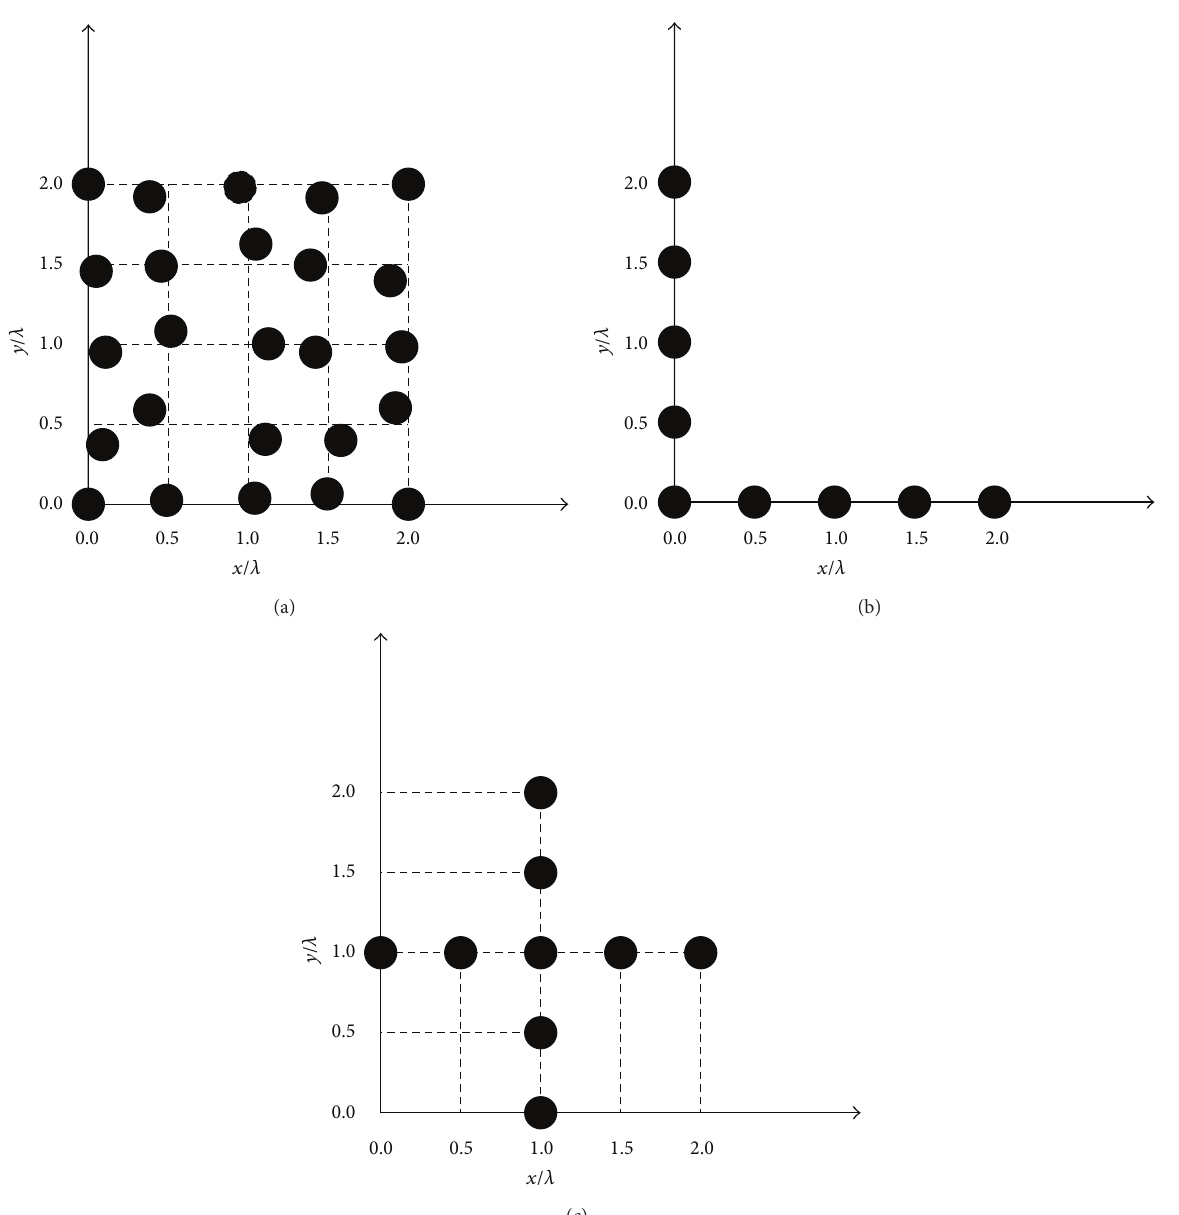
Figure 8: Array geometries comparison—geometries of the receiving (a) random ( 𝑁 = 25 ), (b) L -shaped ( 𝑁 = 9 ), and (c) cross-shaped ( 𝑁 = 9 )